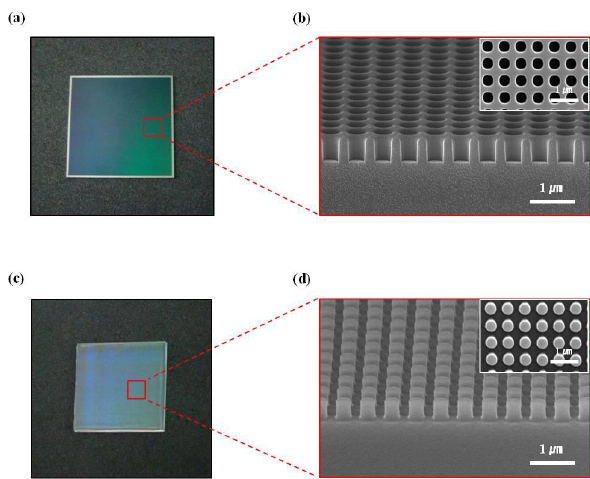
Figure 2. ( a ) Optical image of the uniformly etched Si master nano-mold. ( b ) Cross-sectional and top SEM images of arrayed circular nano-holes with a relief depth of 520 nm. ( c ) Optical image of the replicated MPDMS stamp from the Si master nano-mold. ( d ) Cross-sectional and top SEM images of the replicated MPDMS stamp with a circular pillar structure.